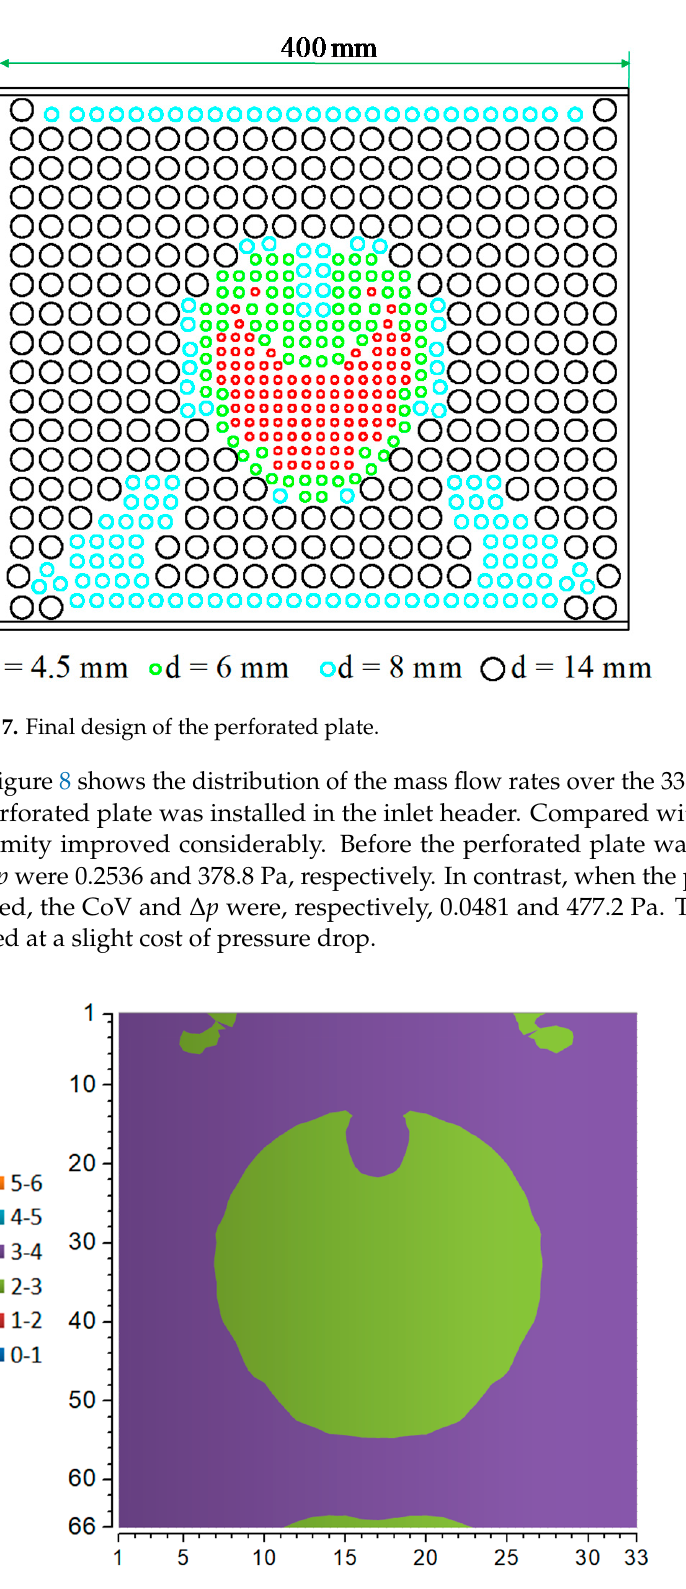
Figure 8. Distribution of the mass flow rates over the 33 × 66 channels when the perforated plate is installed.